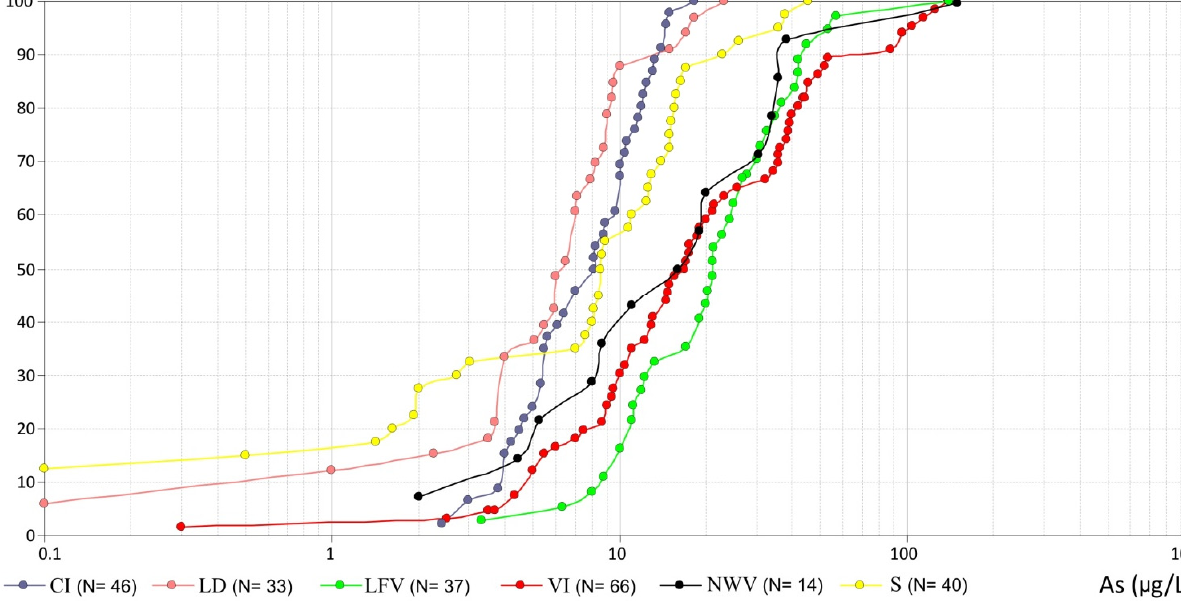
Figure 6. Cumulative frequency plots of arsenic concentrations for the different classes of